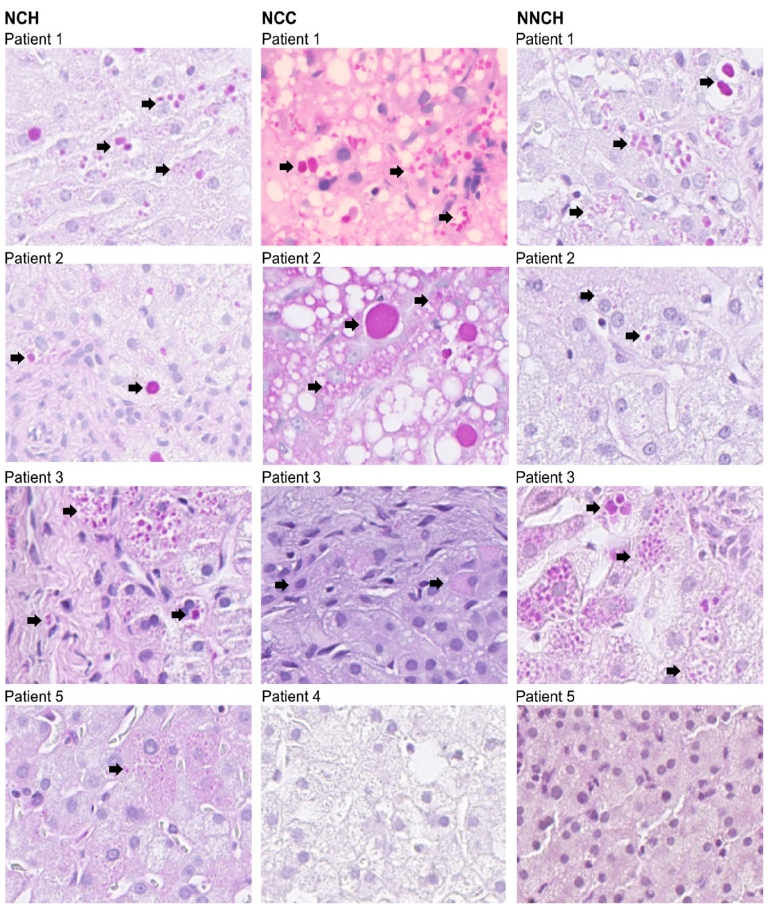
Figure 1. Liver biopsies from PiZZ AATD children ( n = 12, two samples were not available for imaging, these samples are deposited in archives) subjected to PAS ‐ D staining. Arrows indicate PAS ‐ D positive cells.